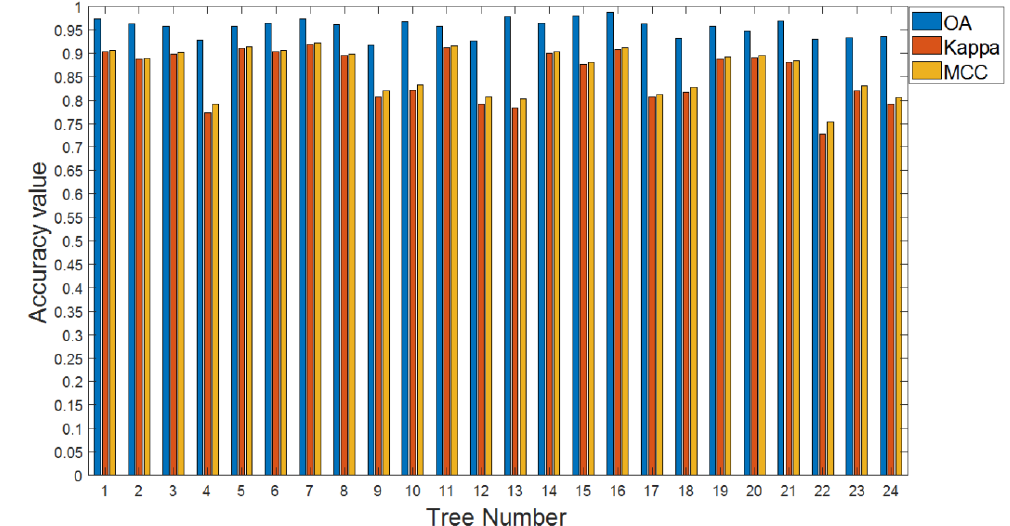
Figure 12. The histogram of OA, Kappa, and MCC of 24 trees’ classification results .